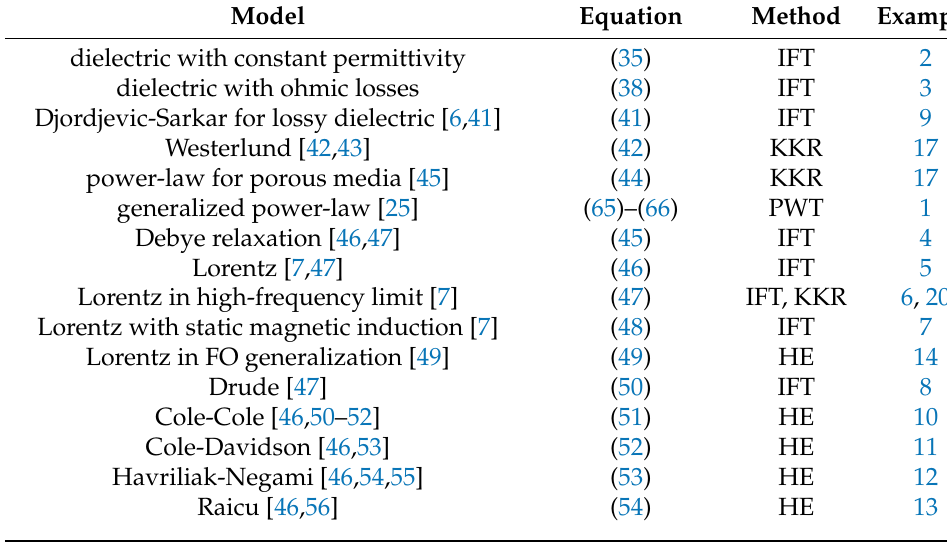
Table 1. Summary of causality evaluation methods for photonic materials (IFT—inverse Fourier transformation, KKR—K–K relations, HE—holomorfic extension, PWT—Paley-Wiener theorem).